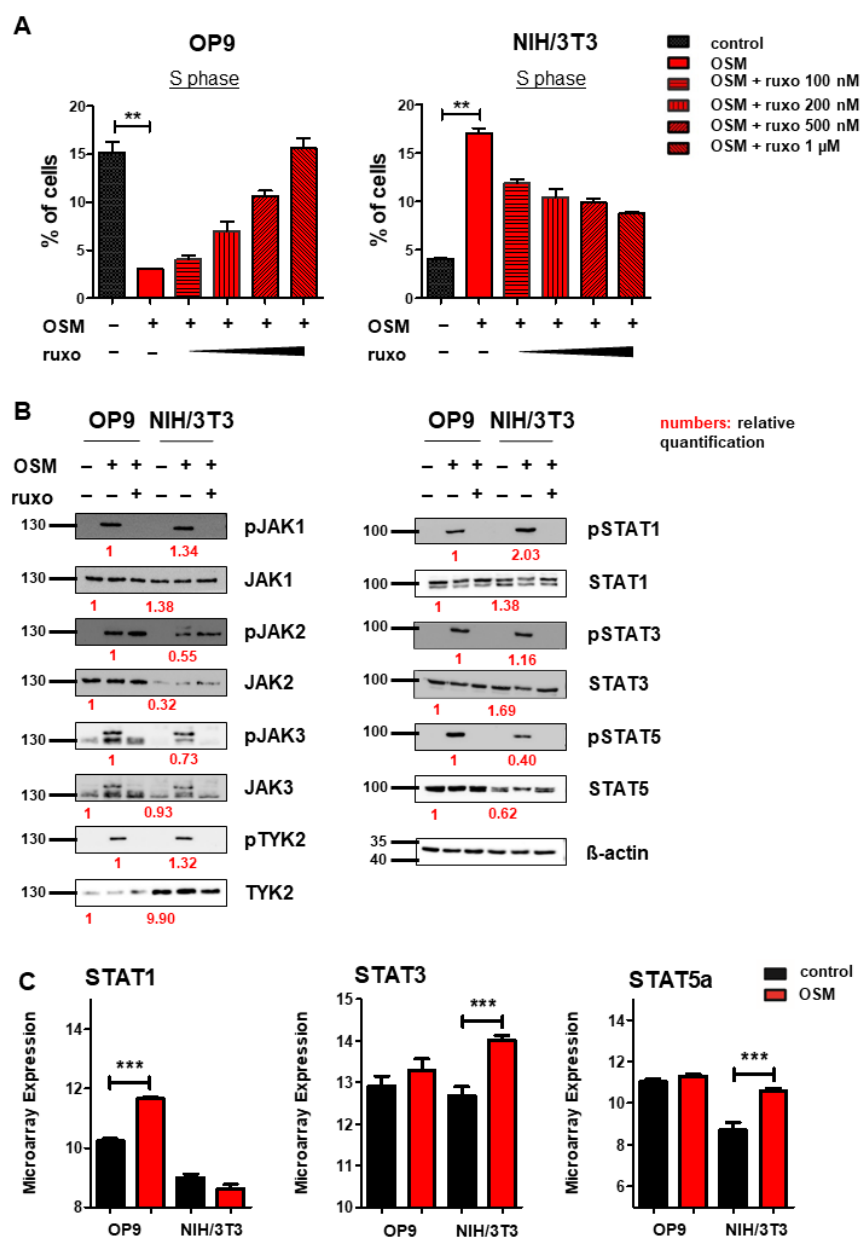
Figure 4. OSM activates the JAK-STAT pathway in OP9 and NIH/3T3 cells. ( A ) Quantification of S phase using an EdU incorporation assay. Cells were serum-starved for 6 h and treated for 24 h with 10 ng/mL mOSM +/ − ruxolitinib (ruxo) at indicated concentrations. Student’s unpaired t -test. ** p < 0.01. ( B ) OP9 and NIH/3T3 cells were used to examine the expression and activation of the JAK-STAT pathway at 10 ng/mL mOSM +/ − 1 µM ruxolitinib. Cells were serum-starved overnight. Ruxolitinib was added for 2 h and mOSM 15 min before harvesting the cells. Protein molecular weight is labeled in kDa. Relative protein quantities are indicated in red. ( C ) Microarray analysis of OP9 and NIH/3T3 cells showing STAT1, 3, and 5a expression. *** p < 0.001.